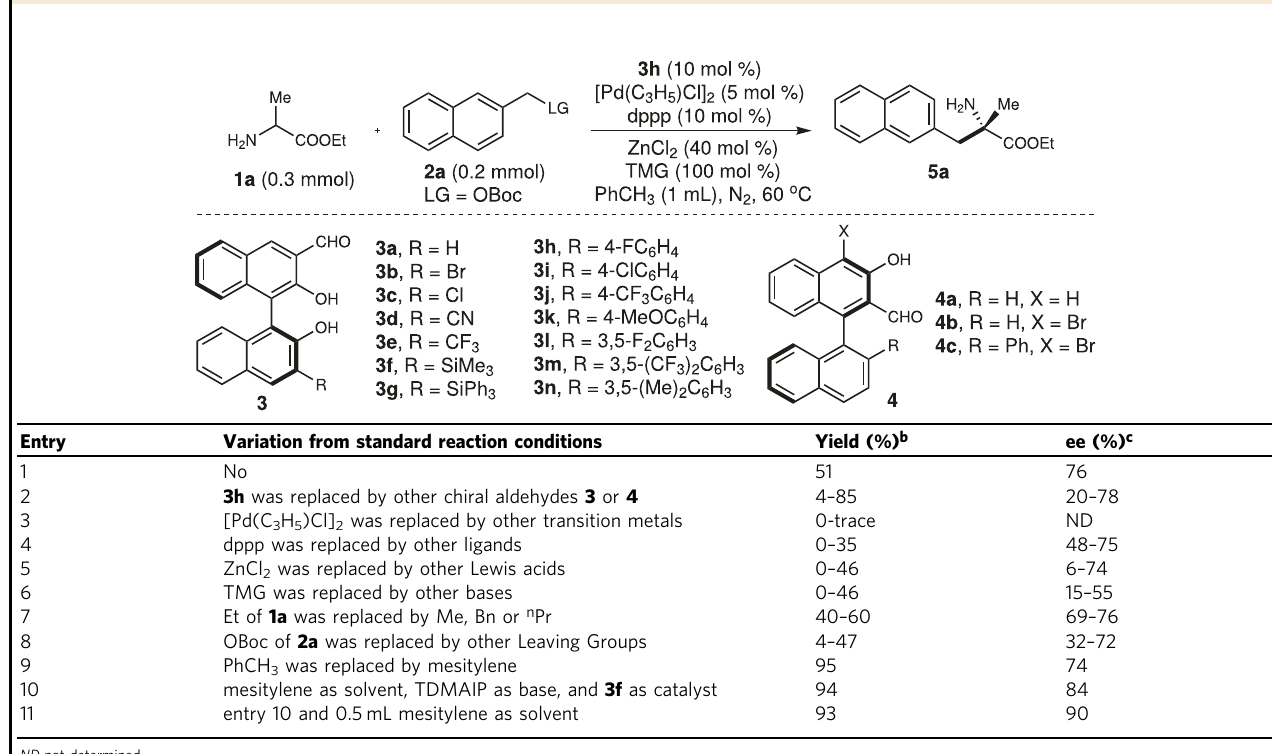
Table 1 Reaction condition optimization of naphthylmethanol involved benzylation a